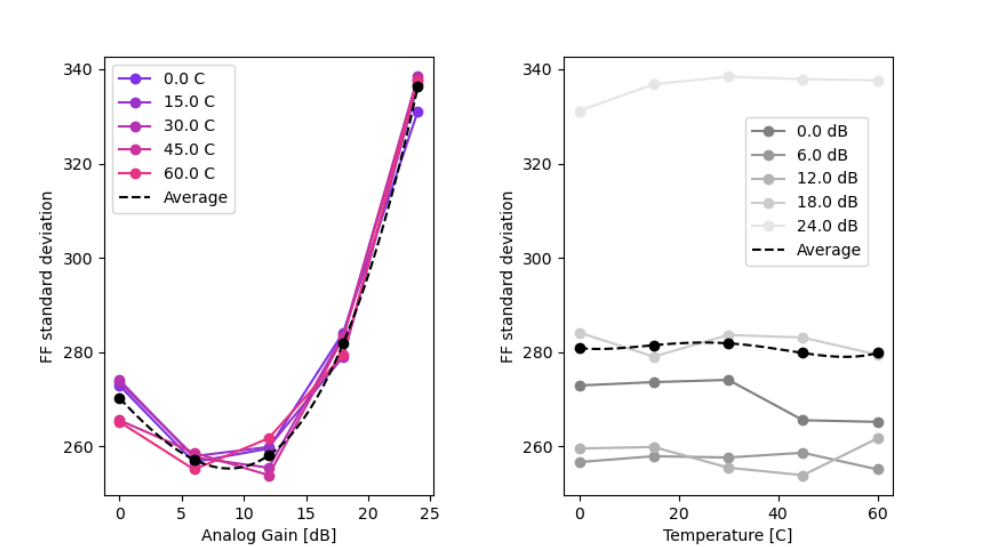
Figure 20. Projections and averages of σ r ( α , T ) .